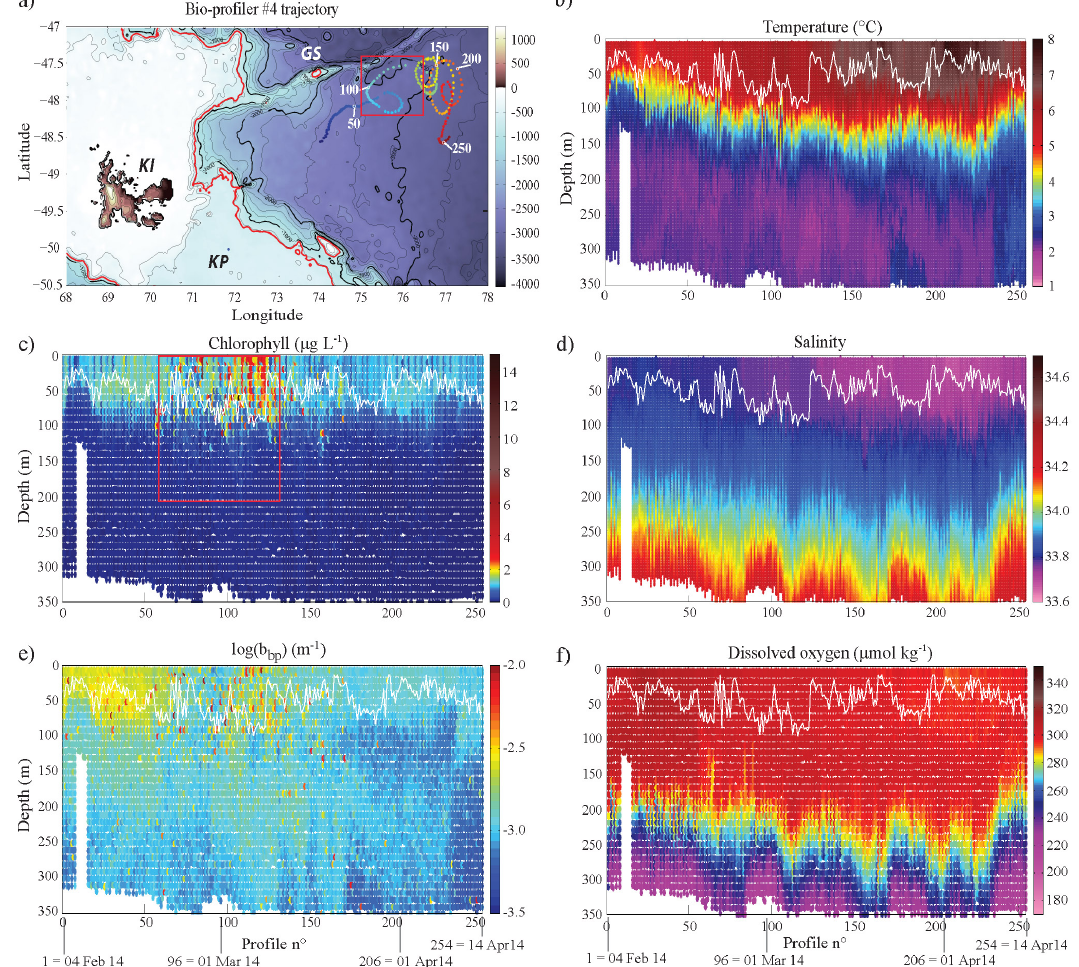
Figure 6. Same as Fig. 3 but for bio-profiler